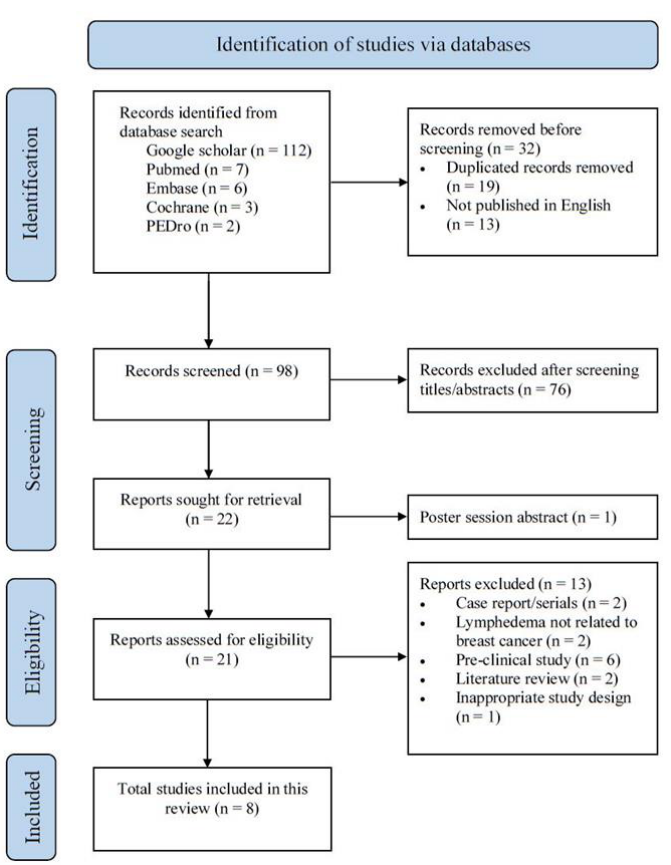
Figure 1. PRISMA2020 flow chart showing literature search and selection process. Table 2. Patients’ characteristics of included